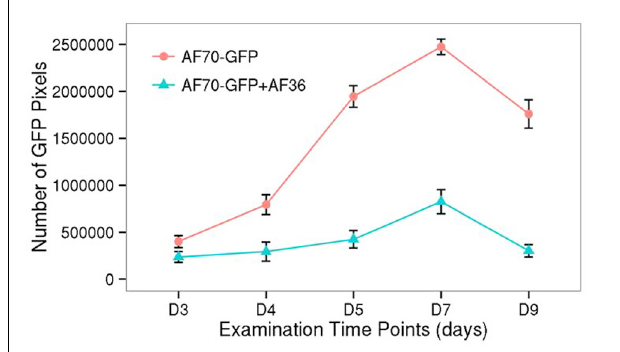
FIGURE 3 | GFP fluorescence at each time point (day 3–day 9 after inoculation), collected as pixel counts, from images of corn kernels inoculated withAF70-GFP + AF36 or theAF70-GFP isolate alone. The AF70-GFP + AF36 mixture is represented by the green line and AF70-GFP alone is represented by the red line.There was a significant treatment effect p < 0.001, and a statistically significant interaction of treatment by day p < 0.001, α = 0.01.